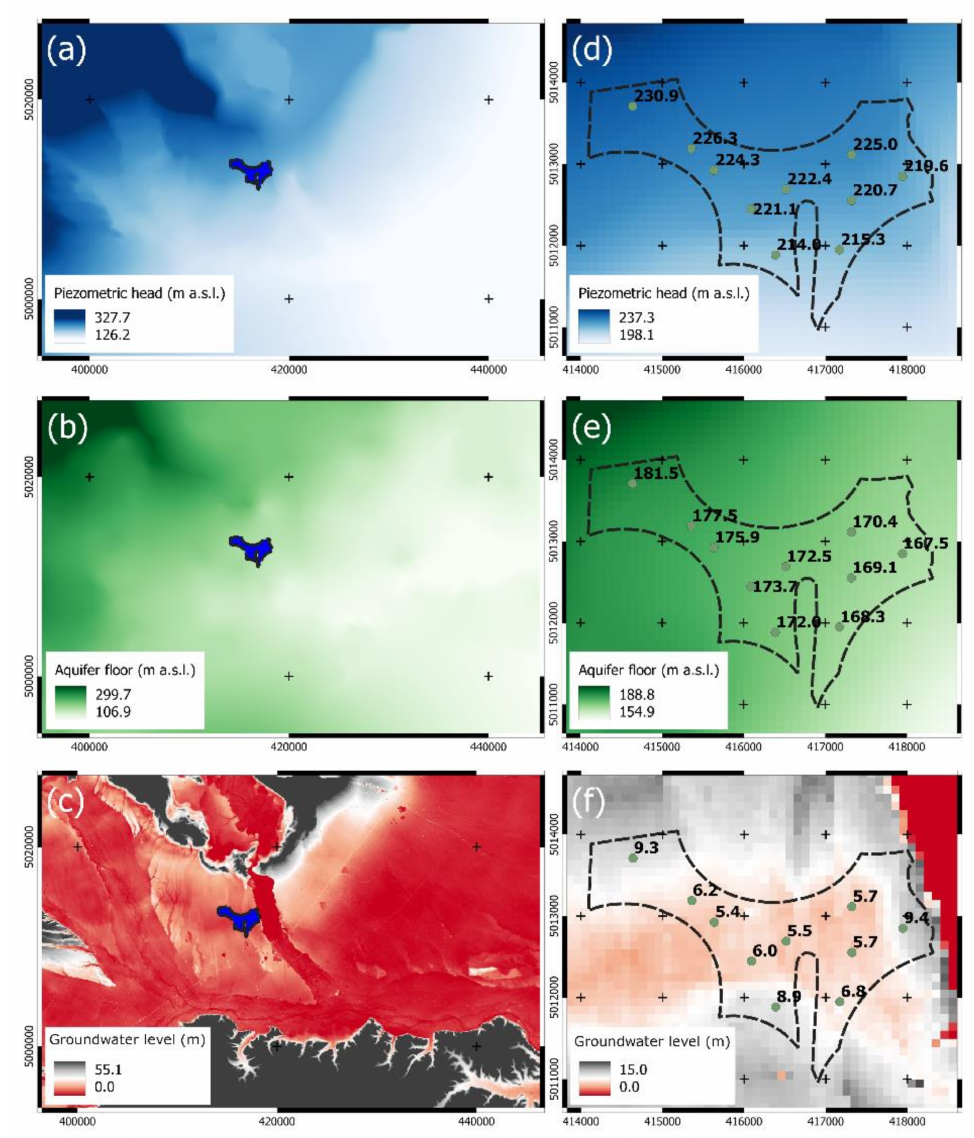
Figure 10. Raster maps of: ( a ) PH(x,y) : altitude a.s.l. of the piezometric head of the aquifer (landscape level); ( b ) AF(x,y): altitude a.s.l. of the floor of the aquifer (landscape level); ( c ) GL(x,y): groundwater level (meters from the ground) of the aquifer (landscape level); ( d ) PH(x,y) in the TO-10 site; ( f ) AF(x,y) in the TO-10 site; ( c ) GL(x,y) in the TO-10 site. In ( a – c ) blue polygon defines the TO-10 area. In ( d – f ) some numerical values are reported for random pixels. Raster maps were generated by spatial interpolation from line vector layers with a grid size of 100 m. Reference system is WGS84 UTM